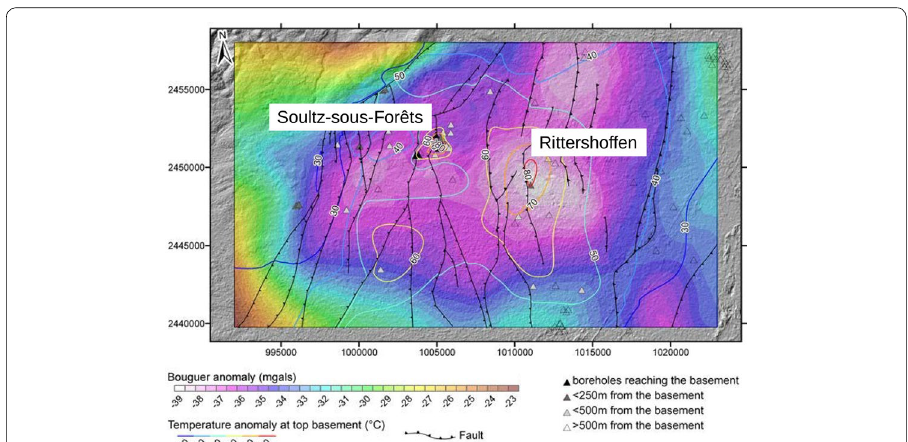
Fig. 2 Bouguer anomalies compared to temperature anomalies in the Soultz area. The reference density is 2670kg m − 3 for the gravity anomaly [figure adapted from Baillieux et al.